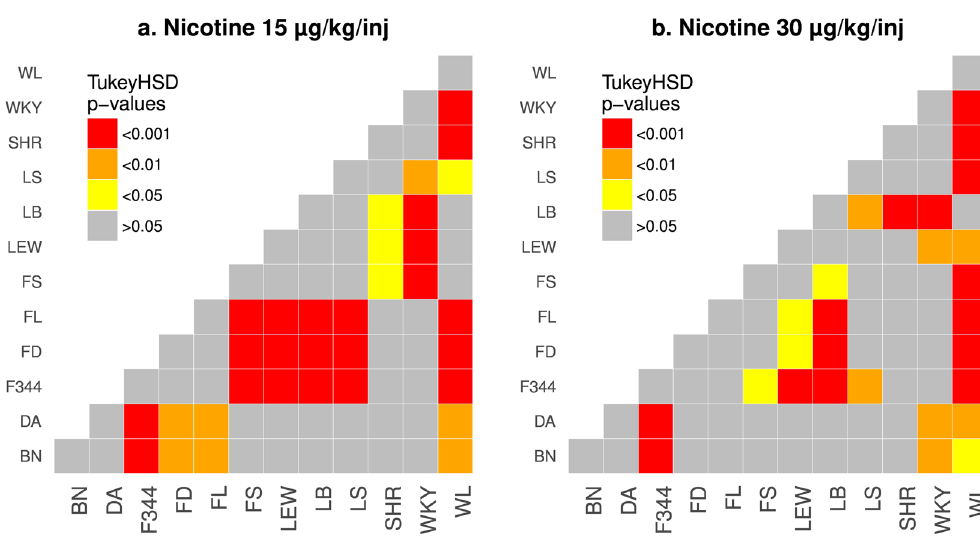
Figure 4. Strain difference. Strain differences in the average number of nicotine infusions obtained during the last three IVSA sessions were analyzed by post-hoc Tukey HSD tests. Each color block represented the p-value when the two strains listed on the x and y-axis were